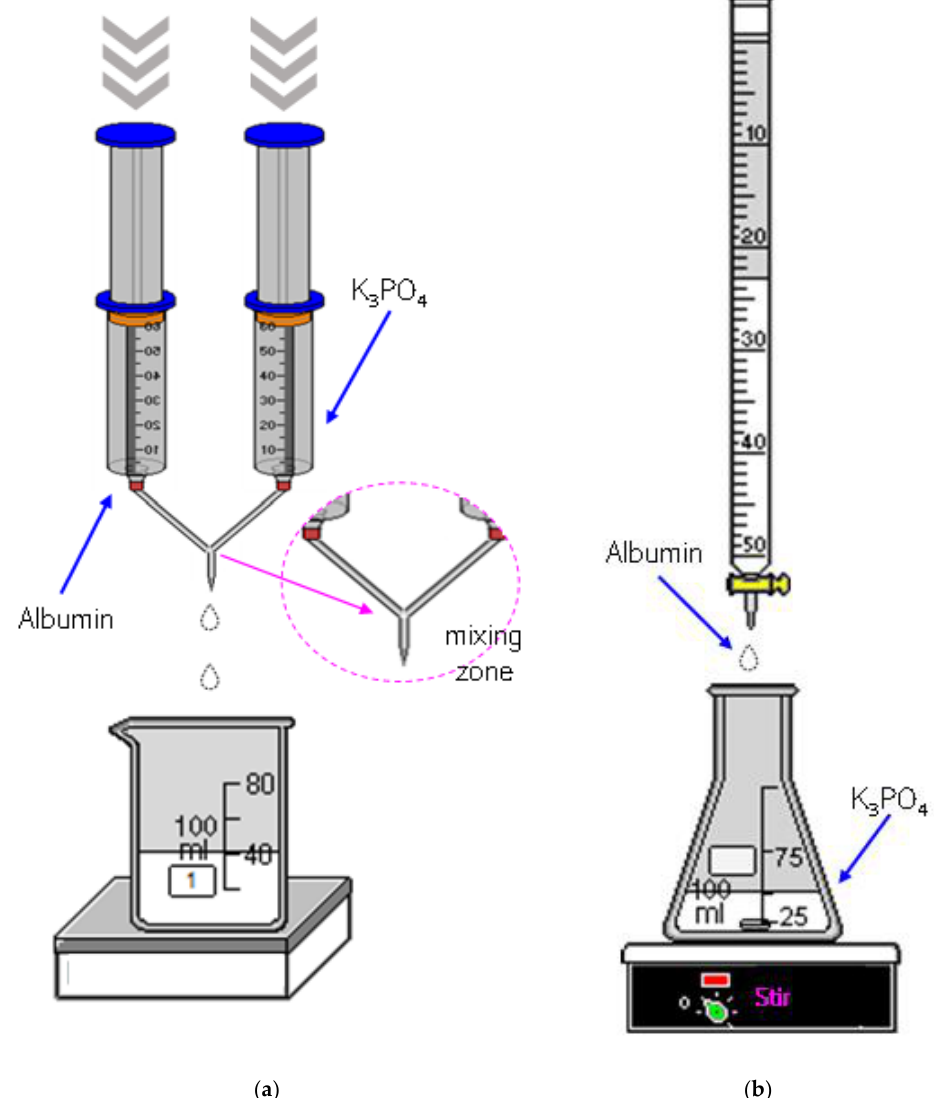
Figure 1. The scheme of the albumin-based carriers synthesis via a syringe system ( a ) and using a burette ( b ).